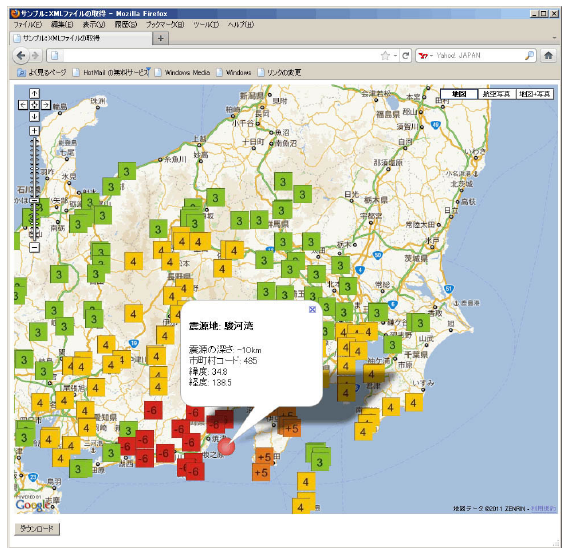
Figure 3. Typhoon scene on Google Maps